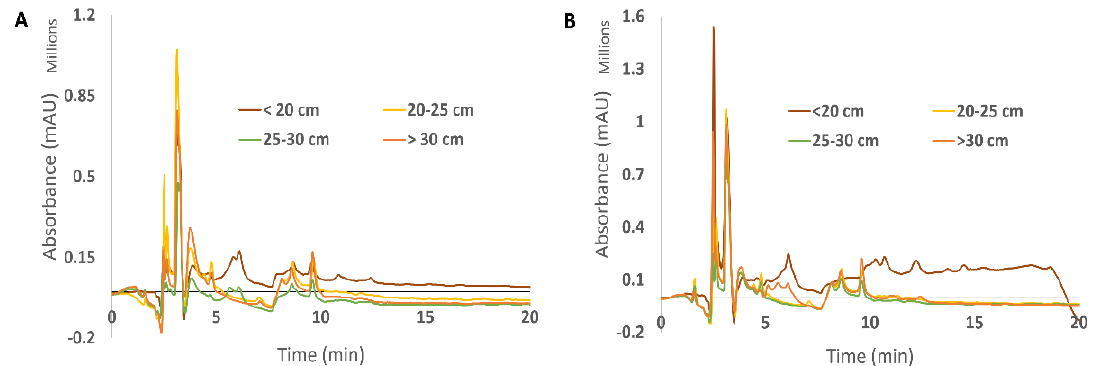
Figure 4. HPLC-DAD chromatographic profile of ( A ) male and ( B ) female samples of F. vesiculosus, extracted at 100 °C (1 mg/mL), across four growth stages—(-) <20 cm, (-) 20–25 cm, (-) 25–30 cm and (-) >30 cm. The y-axis was adjusted according to each respective maximum peak (1,200,000 mAU for ( A ) and 1,600,000 mAU for ( B )).